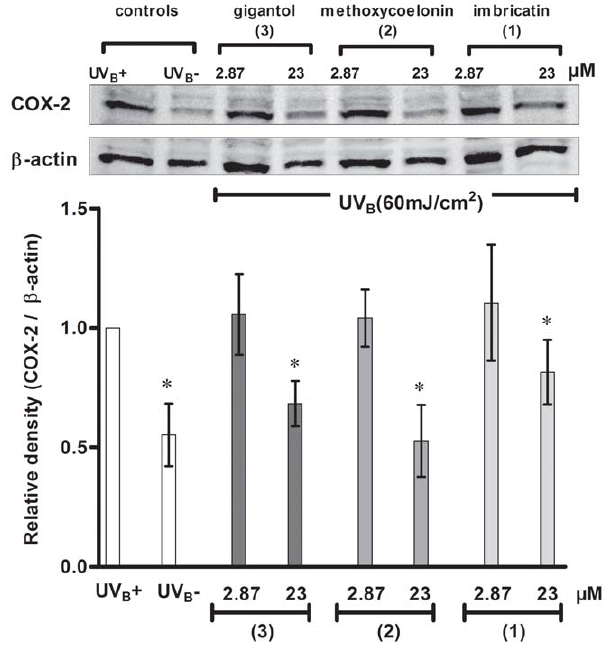
Figure 6. Effect of stilbenoids 1–3 on COX-2 expression in irradiated HaCaT cells. The effect of stilbenoids 1–3 was evaluated on COX-2 expression on HaCaT cells after UVB (60 mJ/cm2) irradiations. Untreated irradiated (UVB + ) and non irradiated (UVB-) HaCaT were respectively used as positive and negative controls. In bar graph, the relative intensity of COX-2 was expressed as a ratio of COX-2/ b -Actin and compared to the positive control UVB + . Statistical significance (*) was set at p , 0.05 compared to the positive control. The three stilbenoids inhibited UVB-induced COX-2 expression at 23 m M, but did not inhibit COX-2 expression at 2.87 m M. Experiment was performed in triplicate with similar results.